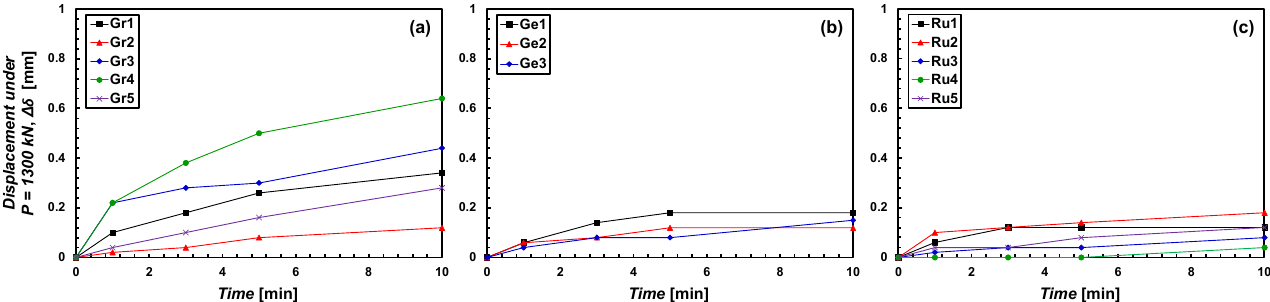
Figure 6. Results of creep tests. ( a ) Micropiles installed using only gravitational grouting ( Gr ), ( b ) geotextile packer ( Ge ), and ( c ) rubber packer ( Ru ).